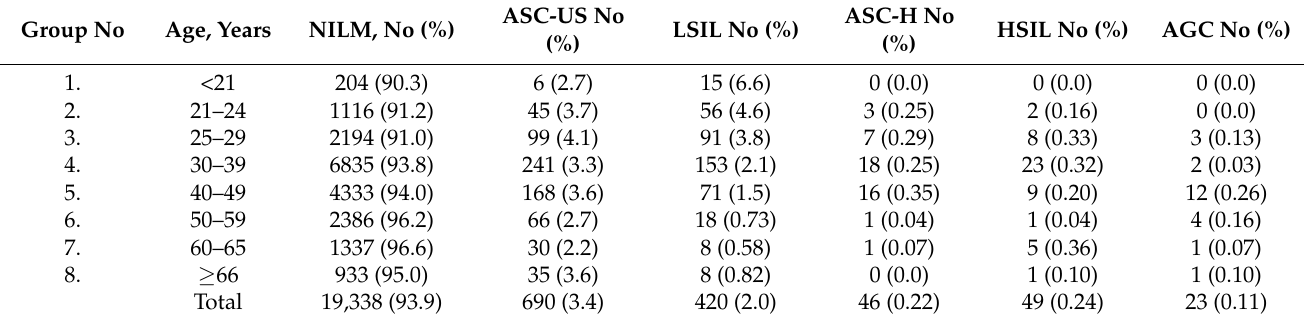
Table 6. Age-stratified NILM, ASC-US, LSIL, ASC-H, HSIL, and AGC reporting rates in the study